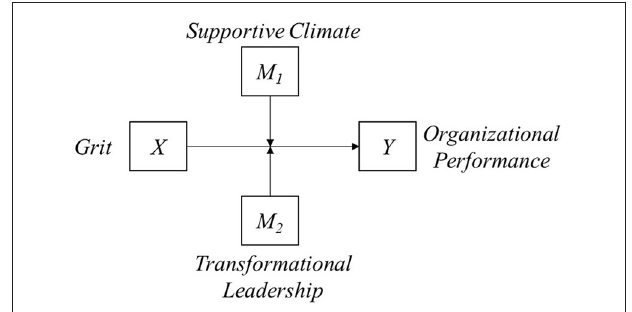
FIGURE 1 | Research model.